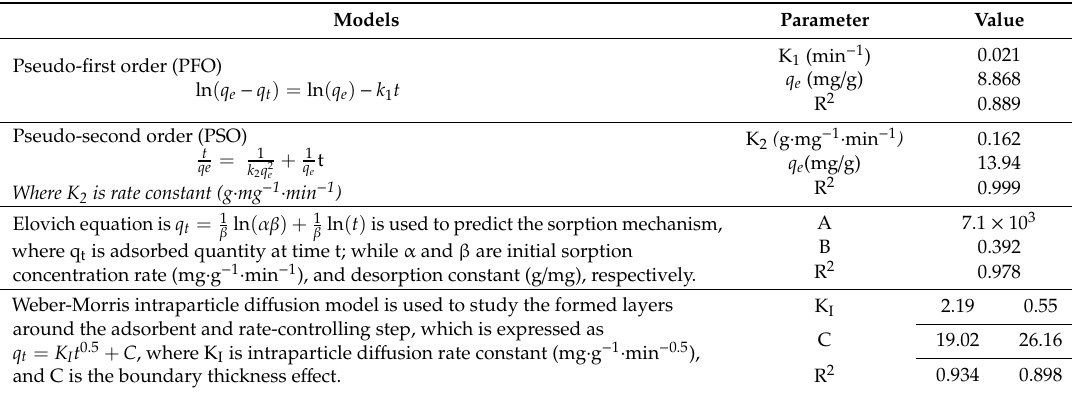
Figure 12. ( A ) First order, ( B ) second order, ( C ) Elovich and ( D ) intra-particle di ff usion (WM) curves of adsorption of SARA onto RPNS. Table 8. The kinetics study results corresponding to Figure